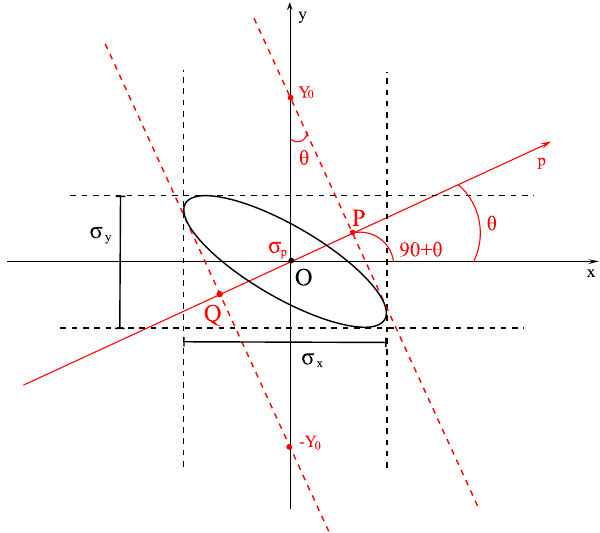
FIG. 6. Sketch of the transverse beam shape reconstruction using tangent lines calculated according to Eq. (6). Black lines represent the laboratory reference system, black dashed lines are drawn considering θ ¼ 0 ° and θ ¼ 90 °, and provide the projec- tion along the x and y axis, σ x and σ y . The red solid line represents the rotation direction of the double-pinhole axis of a generic angle θ , while red dashed lines are the tangent lines calculated taking into account σ p (the distance PQ in the